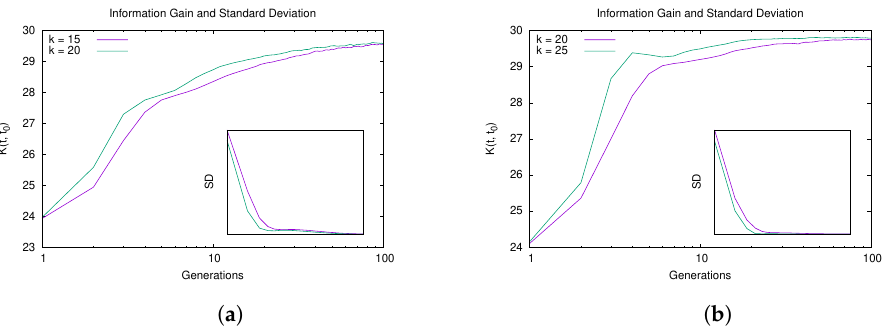
Figure 4. Learning ability of H YBRID -IA: information gain and standard deviation versus gen- erations on ( a ) LFR(1000,15,0.5) and LFR(1000,20,0.5) , and on ( b ) LFR(5000,20,0.5) and LFR(5000,25,0.5)